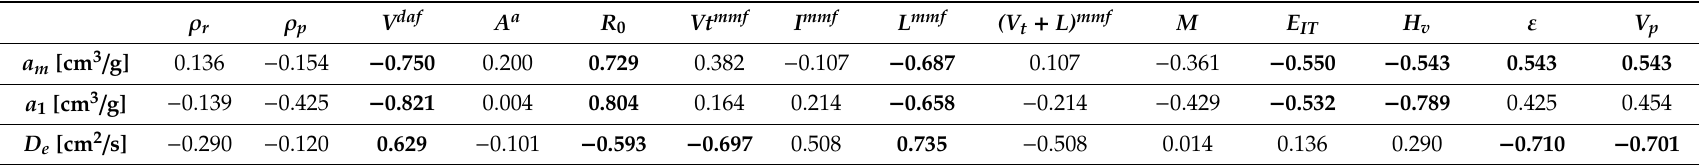
Table 3. Spearman’s rank correlation between sorption and petrophysical parameters of the studied coal samples. Statistically significant correlations (for p < 0.05) are presented in bold